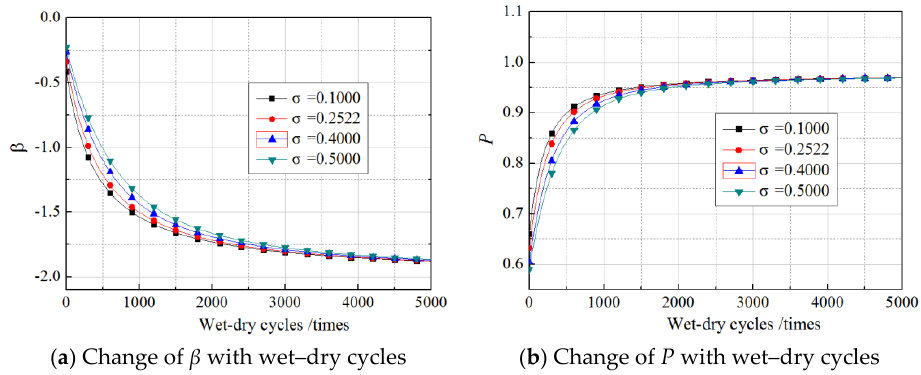
Figure 10. The effects of standard coefficients of the load on the 30% sustained loading specimens.